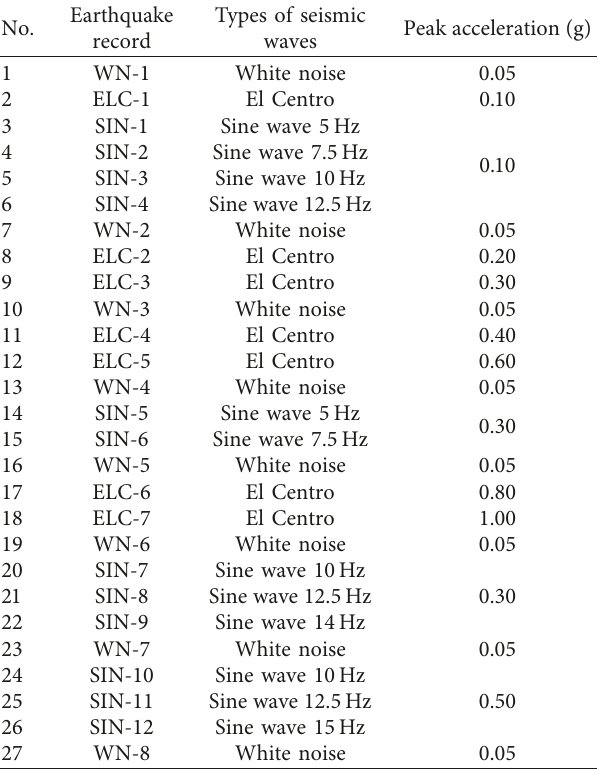
Table 5: The test loading